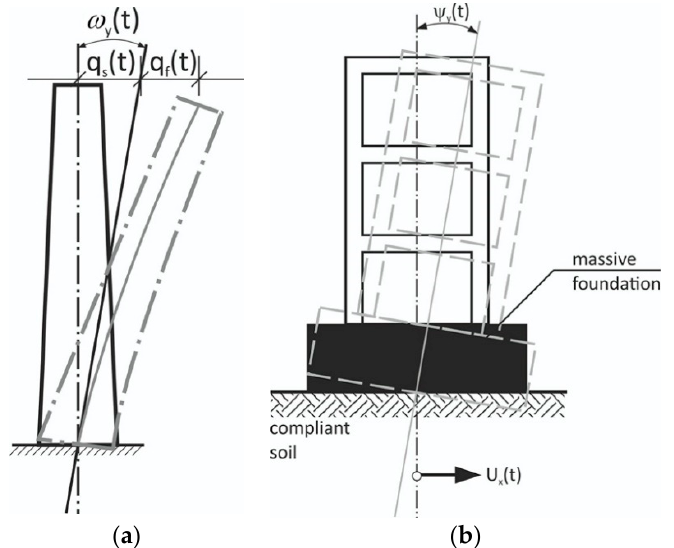
Figure 3. Rocking vibrations of a structure: ( a ) Slender flexible structure fixed to the non-compliant ground, under rocking excitations ω y (t). Its tip response q ( t ) consists of a contribution from the “stiff” rocking excitations and its flexible response: q ( t ) = q s ( t ) + q f ( t ); ( b ) A stiff structure with a massive foundation located on a compliant soil. In this case, rocking vibrations ψ y ( t ) occur even under solely horizontal excitations u x ( t ).